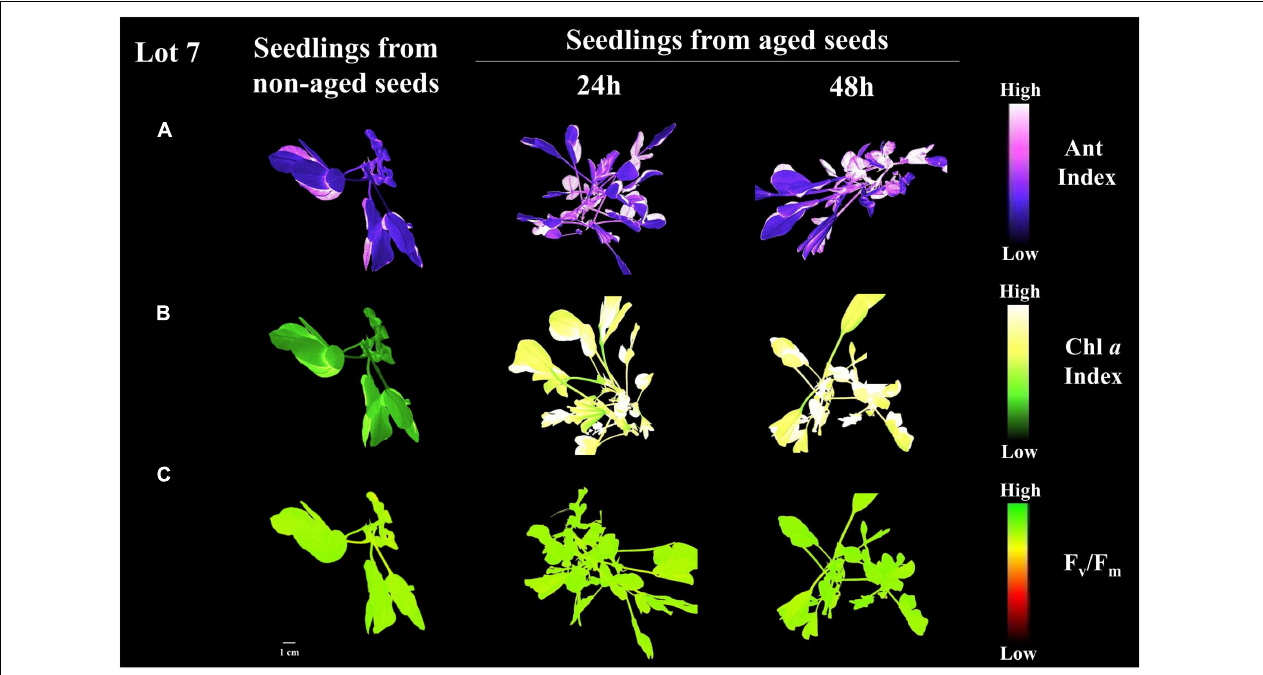
FIGURE 13 | Anthocyanin index (A) , chlorophyll α index (B) , and maximum quantum efficiency of photosystem II based on F v /F m (C) in peanut seedlings ( Arachis hypogaea L.; cv. IAC OL3) from seeds of lot 7 after artificial aging (24 h and 48 h at 42 ◦ C). Each pixel in the image is represented by a unique value that corresponds to fluorescence intensity; higher pixel values indicate higher anthocyanin, fluorescence and F v /F m